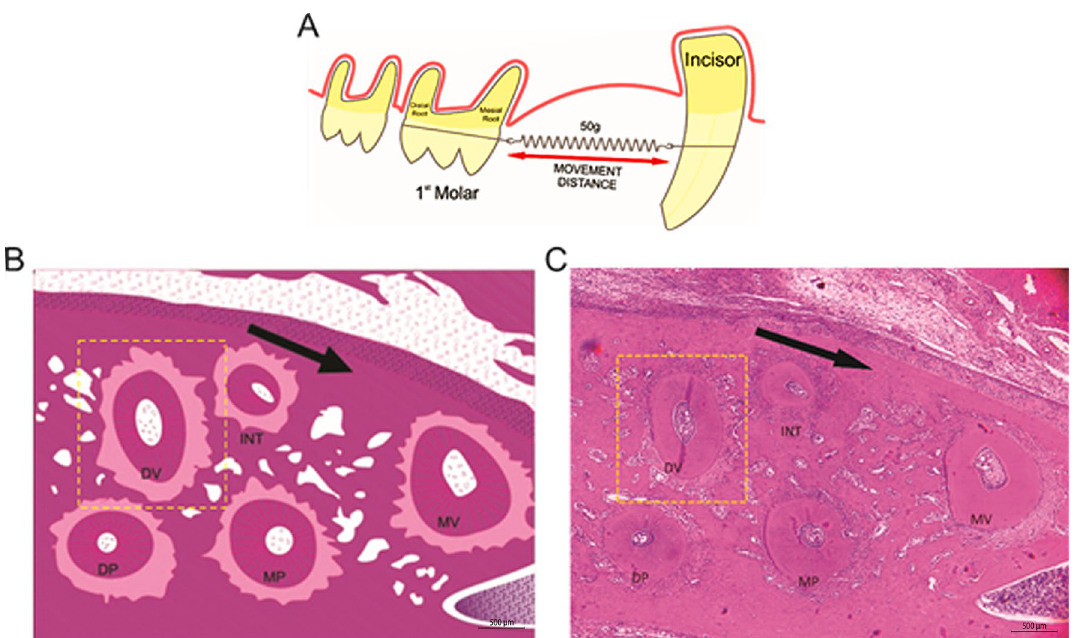
Figure 2. Orthodontic tooth movement (OTM) (A) First left upper molar surrounded by a ligature wire and Niti spring and anchored in the upper incisor teeth. (B) Schematic model of the roots of the rat’s left upper first molar. (C) Photomicrograph of the roots of the rat’s left upper first molar. Five roots (MV, DV, INT, MP and DP) of the maxillary first molar; cross section. Dashed line highlights the DV root, chosen for histomorphometric evaluations. The arrow indicates the direction of the applied force. Bar indicates 500 µm, HE,